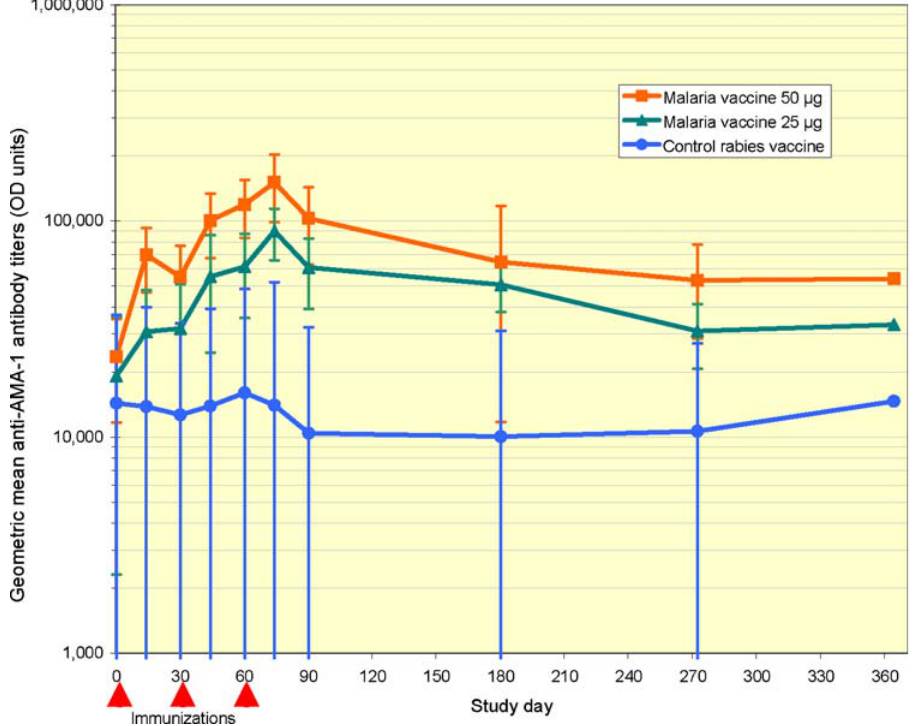
Figure 2. Anti-AMA-1 antibody titers. Geometric mean antibody titers to homologous recombinant AMA-1 for FMP2.1/AS02A full dose, FMP2.1/ AS02A half dose and rabies vaccine recipients. Times of each of three immunizations and the start and end of the malaria transmission season are indicated by triangles. Error bars represent 95 percent confidence intervals.